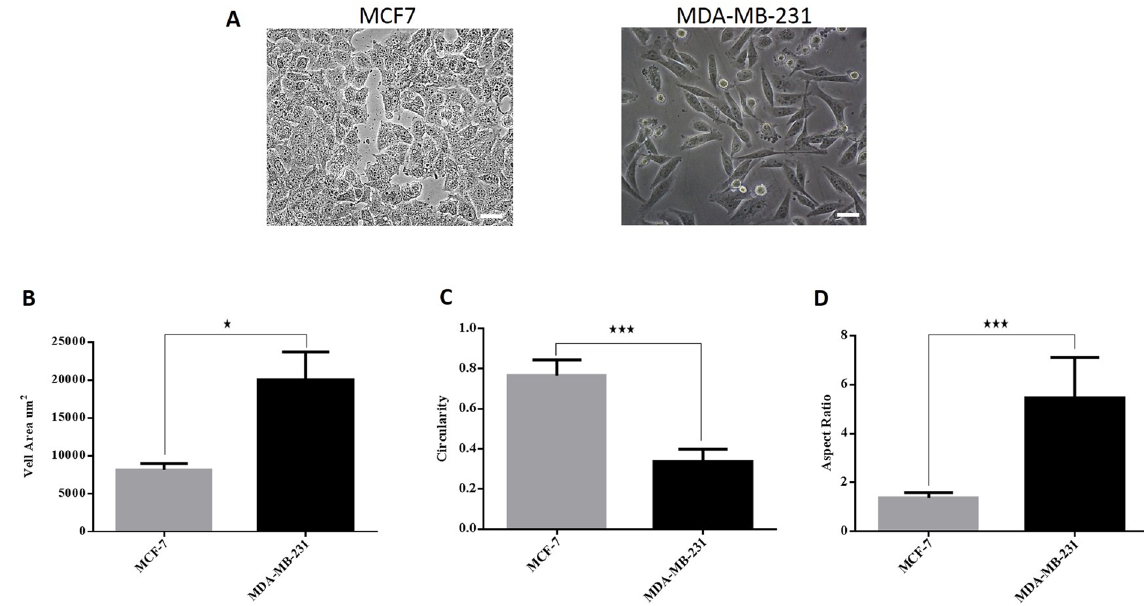
Figure 2. Cellular shapes of MDA-MB-231 and MCF7 cells. ( A ) MCF7 cells showed squamous epithelial cell shape and MDA-MB-231 exhibit spindle-like morphology. Scale bar = 200 µm. ( B ) The mean cell area of MCF7 and MDA-MB-231 cells shows that MDA-MB-231 cells have a larger area compared to MCF7. ( C ) Cell circularity confirms that MCF7 cells have a higher (mean) circularity value compared to MDA-MB-231. ( D ) MDA-MB-231 cells have an aspect ratio above 5 while the round shape of MCF7 is reflected by an aspect ratio ~